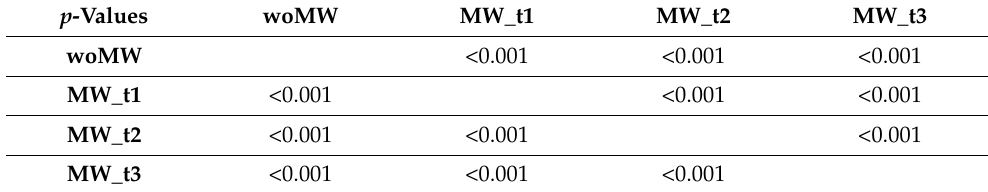
Table 7. Statistically significance values from MANOVA (PCA) test with selected parameters. p -Values